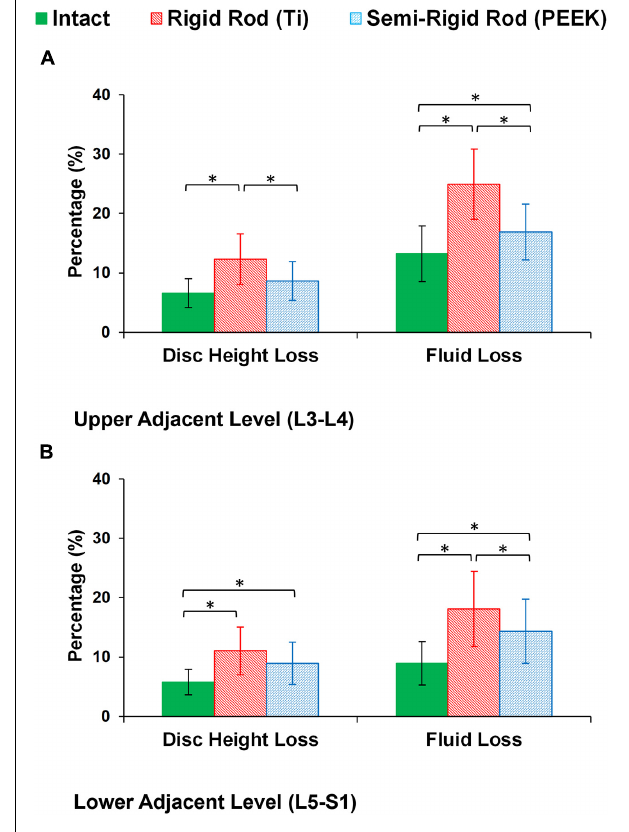
FIGURE 8 | Percentage of disc height loss and fluid loss for postoperative FE models in the (A) upper adjacent level (L3–L4) and (B) lower adjacent level (L5–S1). The error bars indicate the standard deviations, and “ ∗ ” shows that p values <